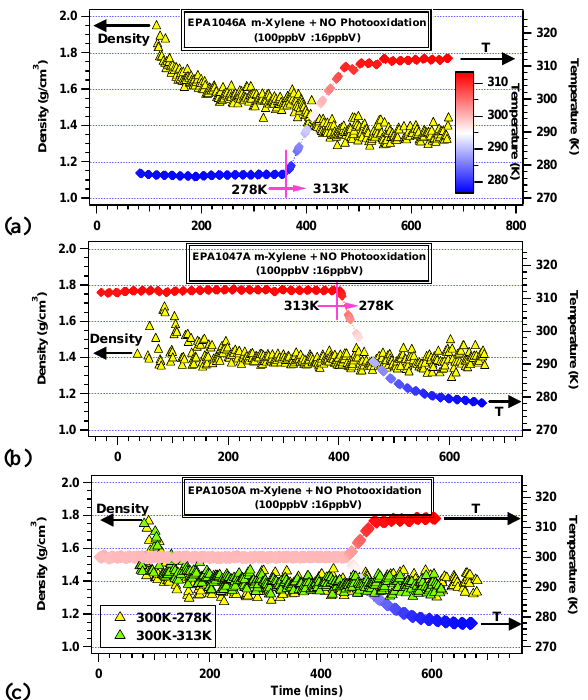
Fig.2 The time evolution of particle density for four selected temperature experiments: initial concentrations m -xylene ≈ 100 ppb, NO 2 ≈ 16 ppb for (a)-(c); (a) 278 K (cid:198) 313 K, (b) 313 K (cid:198) 278 K, (c) 300 K (cid:198) 278 K; 300 K (cid:198) 313 K.